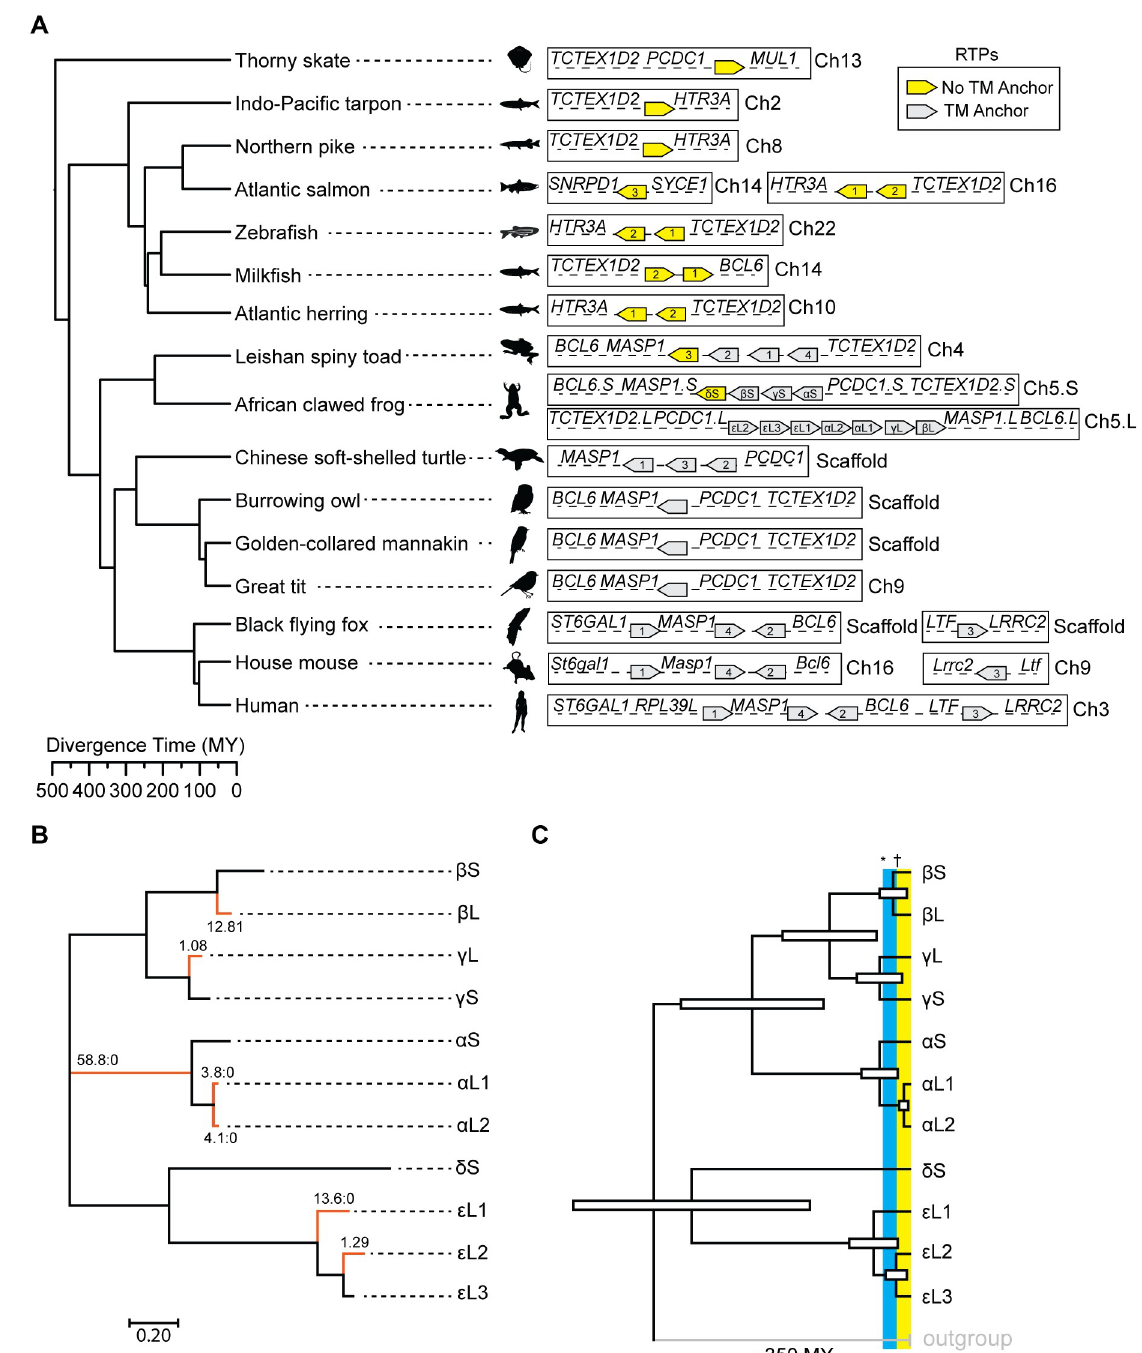
Fig 2. RTP locus synteny and evolutionary analysis of X . laevis RTPs. A) Left: A TimeTree [51] of representative RTP-containing vertebrate species. Right: chromosomal arrangement of RTPs. Common proximal genes and chromosome numbers, when available, are indicated. Numbering of RTP genes, when indicated, matches the numbering used in Fig 1B, File A in S1 File, and S4 Table. Scaffold denotes contigs that are not mapped to chromosomes. B) Free-ratio analysis of X . laevis RTPs. Annotated values indicate the dN/dS of each branch. Branches with dN/dS > 1 are marked in red. C) A TimeTree for X . laevis RTPs inferred using the Reltime method [52,53] and the Tamura-Nei model [54]. Divergence times were estimated by calibration by designating mammalian RTP4 sequences as an outgroup. The estimated log likelihood value is -9335.49. A discrete Gamma distribution was used to model evolutionary rate differences among sites (5 categories (+G, parameter = 2.9731)). The rate variation model allowed for some sites to be evolutionarily invariable ([+I], 6.22% sites). White rectangles denote 95% CI of divergence times. Asterix ( � ) indicates estimated L and S genome divergence time. Dagger (†) indicates estimated L and S genome hybridization time. https://doi.org/10.1371/journal.pgen.1009578.g002 PLOS Genetics | https://doi.org/10.1371/journal.pgen.1009578 May 20,